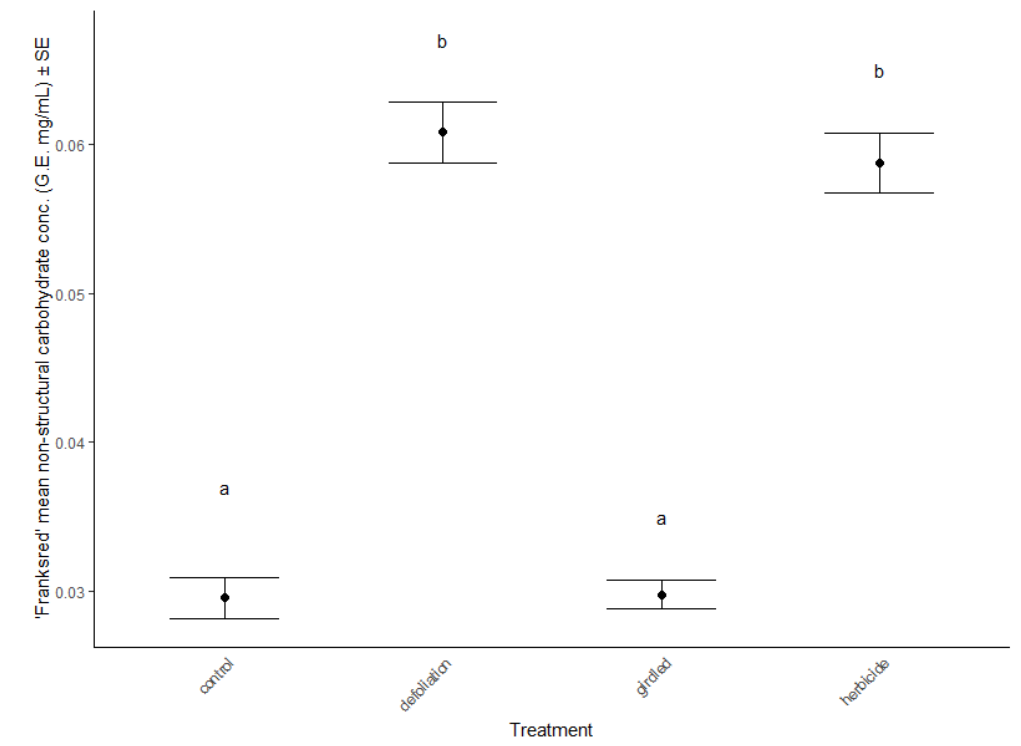
Figure 6. Total non-structural carbohydrates (combined sugars and starches) in foliage of stress treatments in June, after reflush of defoliated and herbicided treatments. ( a ) ‘Brandywine’ and ( b ) ‘Franksred’ cultivars of red maples ( Acer rubrum ). G.E. = glucose equivalents (see methods for details). Different letters represent statistical differences between treatments according to a post hoc Tukey HSD analysis.